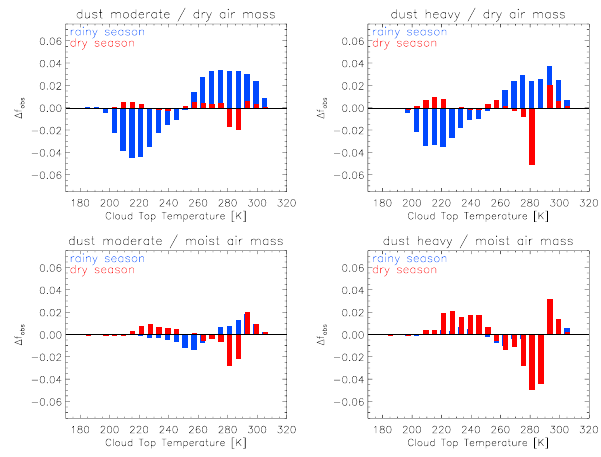
Fig. 4. Observation density differences of MODIS cloud top tem- perature for moderate (left) and heavy dust (right) classes and dif- ferent flow regimes (air masses) during the wet (blue) and dry (red)